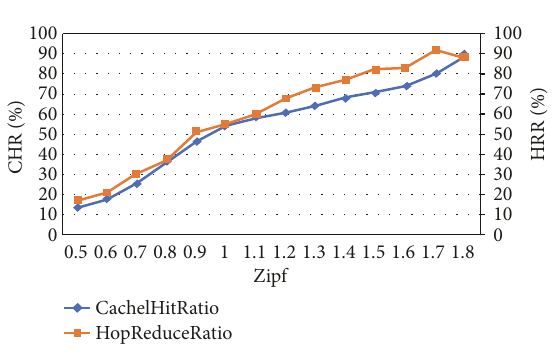
Figure 8: Effect of Zipf with CHR and HRR.